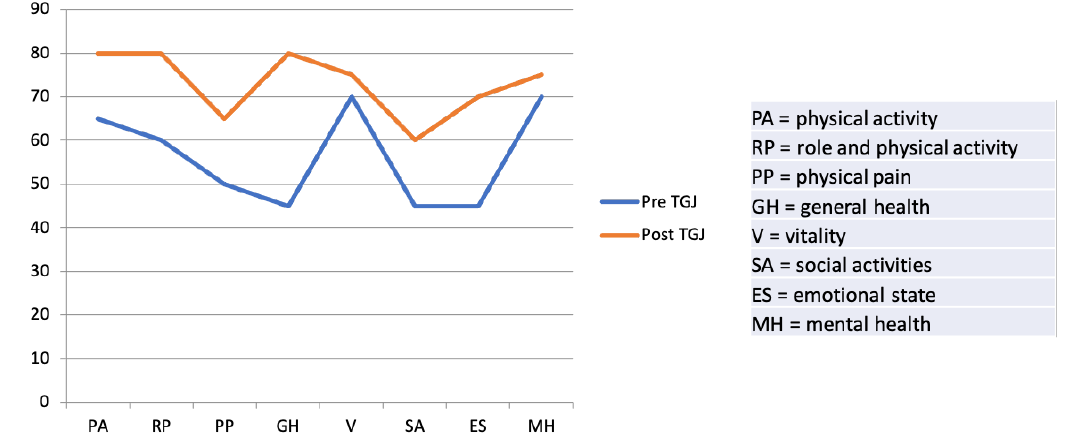
Figure 1. Results from Short-Form 36 questionnaire version 1.6: mean value of each item. We recorded a significant improvement in QoL after TGJ placement, as recorded by higher scores in all 8 items considered. In particular, the biggest improvements were related to parents’ perception of the general health (GH) and emotional state (ES) of their babies, whose scores increased by 35 and 25 points respectively (from 45 to 80 for GH and from 45 to 70 for ES, p < 0.01). Physical activity (PA) and pain (PP) improved by 15 points but while PA reached high levels of satisfaction (65 vs. 80 after TGJ placement), PP remained a limiting factor for families (mean score of 50 and 65, respectively before and after TGJ placement, p < 0.01). Likewise, social activities, which were very limited before TGJ placement (45 points), improved, reaching a mean score of 60 ( p < 0.01). Vitality (V) and mental health (MH) were quite satisfactory before TGJ placement, but subsequently improved slightly (score of 70 vs. 75 p < 0.01).